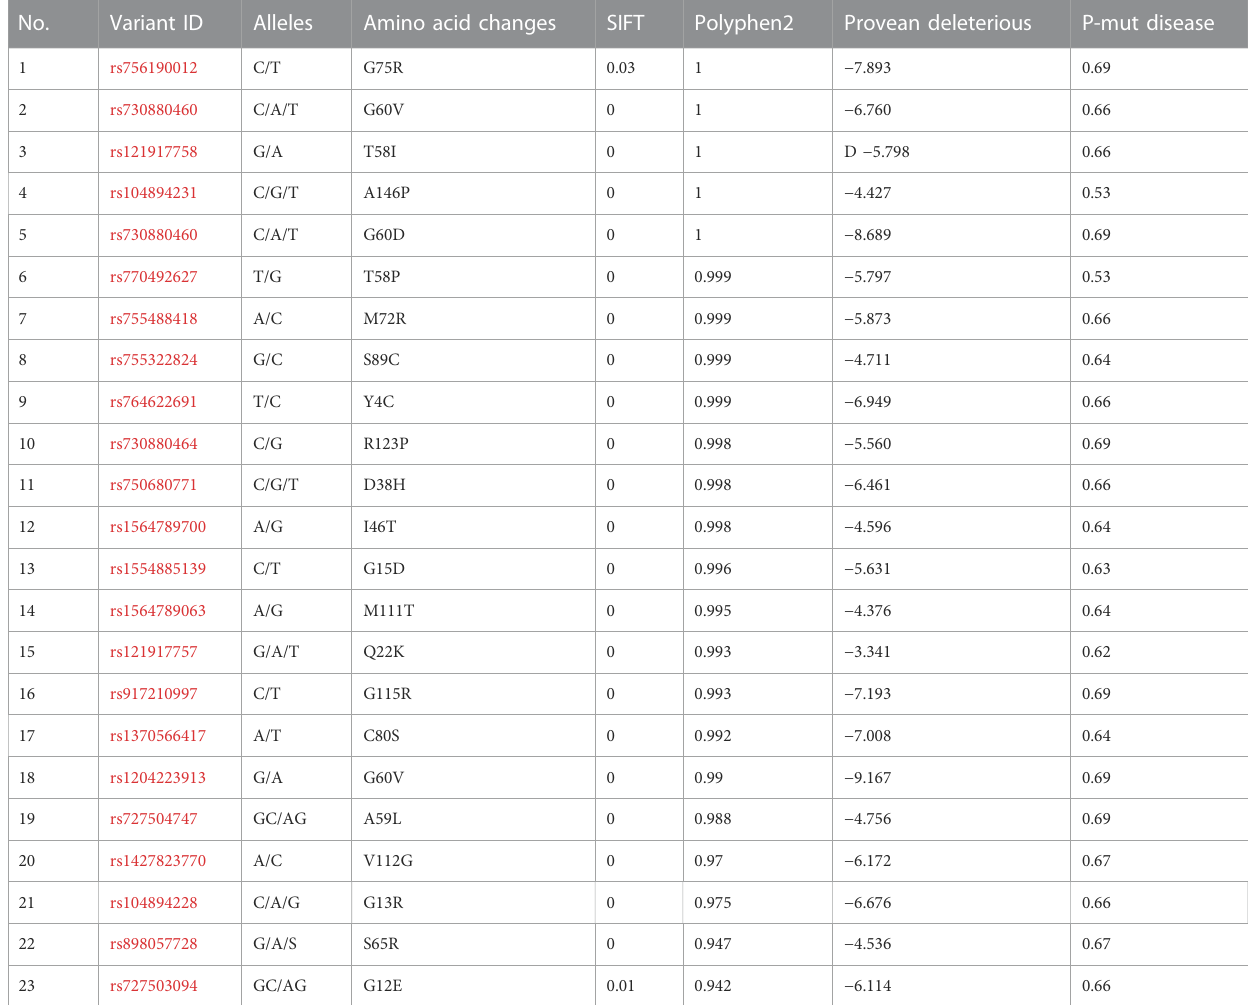
TABLE 1 Screening of most deleterious SNPs by using different software.